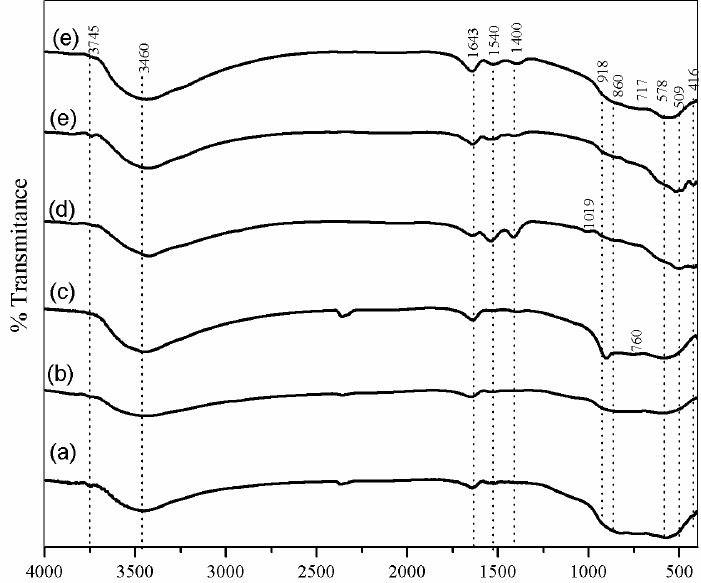
Figure 3. FTIR spectra: ( a ) γ -Al ( c ) KMnO impregnated on γ -Al 4 ( f )